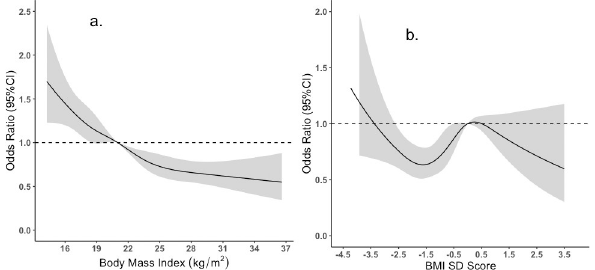
Fig 8. The Odd of being anemic from Restricted Cubic Splines (RCS) regression for Women (Picture a.) and Children (Picture b.). [The reference BMI for women was set at 21 (median of BMI for normal weight) and for Children reference BMI SD score at